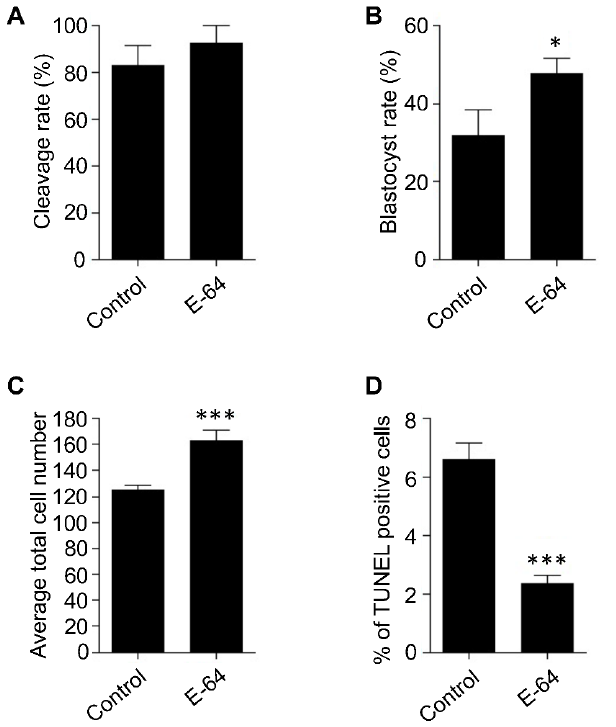
Figure 1. Effect of E-64 supplementation during in vitro maturation on the developmental rate and the quality of preimplantation embryos. Bovine COCs were collected separately from slaughterhouse ovaries of the same animal followed by in vitro maturation in the presence or absence of 1 µ M of E-64. After in vitro fertilization, presumptive zygotes were cultured for 7 days. Cleavage ( A ) and blastocyst ( B ) rates were observed on days 2 and 7, respectively. Total number of oocytes used is 166. Total cell number of day 7 blastocysts was counted with DAPI ( C ). The apoptotic status of day 7 blastocysts was detected by TUNEL staining ( D ). Total number of embryos used is 44. The experiments were carried out at least three times. The data are expressed as mean ± SEM. Values with asterisks vary significantly, * p < 0.05, *** p < 0.001.